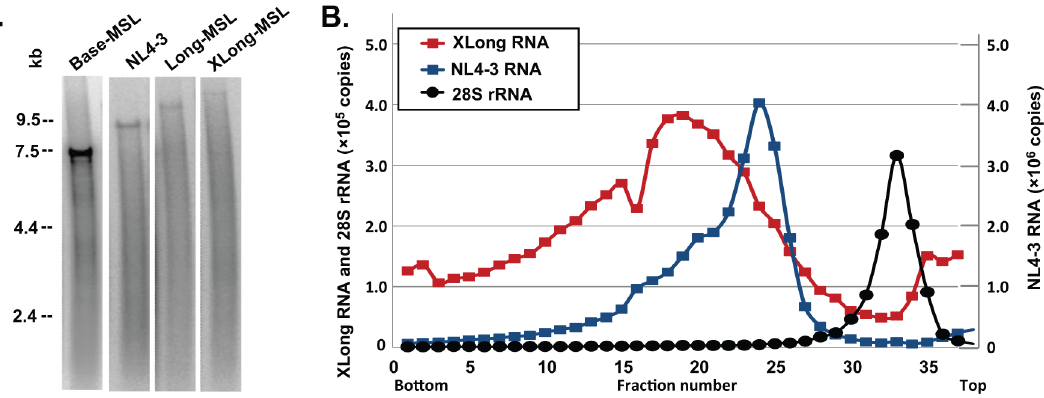
Figure 2. Biochemical analyses of HIV-1 virion RNAs. (A) Representative denaturing Northern analyses of virion RNAs. The four lanes shown are generated from the same gel and rearranged for clarity. (B) Representative analyses of velocity sedimentation of virion RNAs. The copy numbers of XLong and 28S rRNAs are shown in the y axis on the left, whereas the copy numbers of the NL4-3 RNA are shown in the y axis on the right.